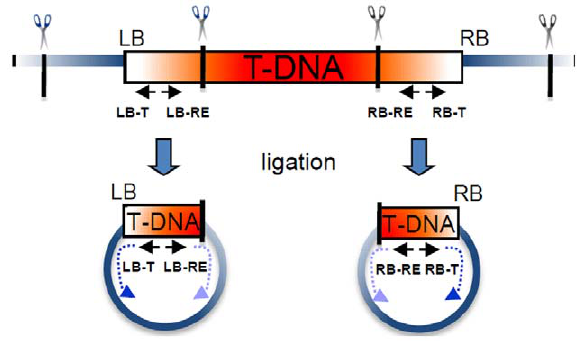
Figure 4. IPCR strategy for obtaining T-DNA flanking sequenc- es. The diagram illustrates the IPCR strategy used to obtain sequences flanking the T-DNA insertion sites (ISs). Restriction enzymes (shown as scissors) with recognition sites (black lines) near the T-DNA border sequences (LB and RB) were used to digest DNA from T-DNA insertion lines. Enzymes cut both within the T-DNA and genomic sequence, and ligations were performed to circularize purified digestion products. PCR of the ligation products was performed using T-DNA specific primers and sequencing was performed with nested primers. The orientations and locations of primers with respect to restriction sites are shown as black arrows. Primers located within the T-DNA directed toward the junction with genomic DNA are designated T primers (LB-T and RB-T). Sequencing reactions using these primers return genomic sequence directly adjacent to the IS (dark blue dotted arrows). Primers directed into the T-DNA are designated RE primers (LB-RE and RB-RE). After enzyme digestion and ligation, sequencing reactions using these primers return genomic sequence starting from the closest restriction enzyme recognition site within the Brachypodium genomic sequence and directed toward the T-DNA insertion (light blue dotted arrows).